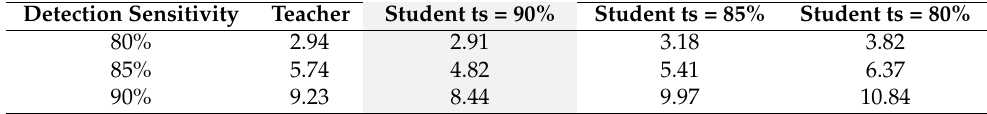
Table 2. AFP vs sensitivity for different ts values. Table 2. AFP vs. sensitivity for different ts values.